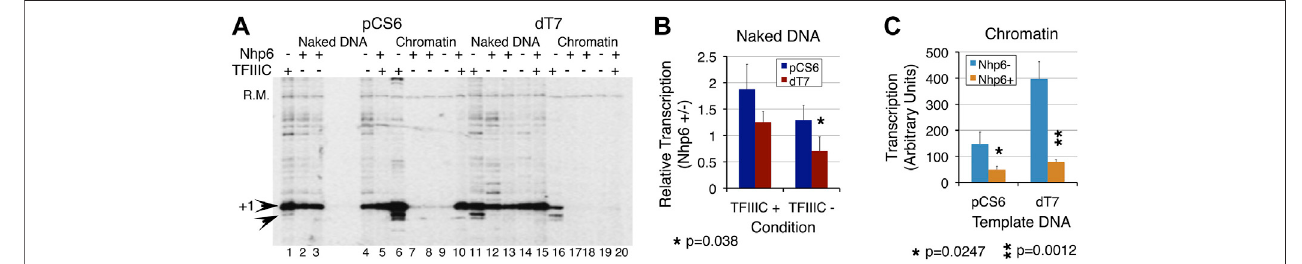
FIGURE4| T7promoterelementisrequiredfortranscriptionrepressioneffectsofNhp6.TranscriptionofpCS6anddT 7 wasfollowedwithorwithoutNhp6addition (Nhp6+/ − ) in the presence/absence of TFIIIC. Measured transcript levels were obtained by normalizing with the recovery marker and the ratios of transcript levels in the presence/absence of Nhp6 were obtained separately for the transcription performed with/without TFIIIC (TFIIIC + or TFIIIC-) addition. (A) Nhp6 effect was followed with the addition of108 ng Nhp6 in thelanes3, 5, 8, and 10 for pCS6 and 13, 15, 18, and 20 for dT 7 templates. Arrowheads mark the position oftranscripts initiated at +1 and +5 bp positions. Nhp6 abolishes background, non-speci fi c transcription seen only in the presence of TFIIIC. The results were analyzed for ND and chromatin separately.Read-outoftheNhp6effectfornakedDNA (B) isgivenastheratiooftranscriptyieldinthepresence/absenceofNhp6(Nhp6+/-).Valuesofratioslessthan1 denote repression by Nhp6 whereas those more than 1 denote activation, over the transcription level in the absence of Nhp6. The p values for measurements from 3 – 4 independent experiments are given; p value 0.038 compares the transcript levels from pCS6 and dT 7 in the absence of TFIIIC. In contrast to ~1.29-fold ( p = 0.13) activationforpCS6,dT 7 transcriptionshowsfurther44%lossintheTFIIICabsence( p =0.032). (C) ClosetobackgroundchromatintranscriptionintheabsenceofTFIIIC giveshighscatterinmeasurements.Becauseofthis,onlyTFIIIC-dependenttranscriptionintheabsenceorpresenceofNhp6wasquanti fi ed.Nhp6additionreducedthe transcription similarly for pCS6 (3-fold, p = 0.0247) and dT 7 (~5-fold, p = 0.0012). Asterisk marks the signi fi cant differences; the p values are given at the bottom of the